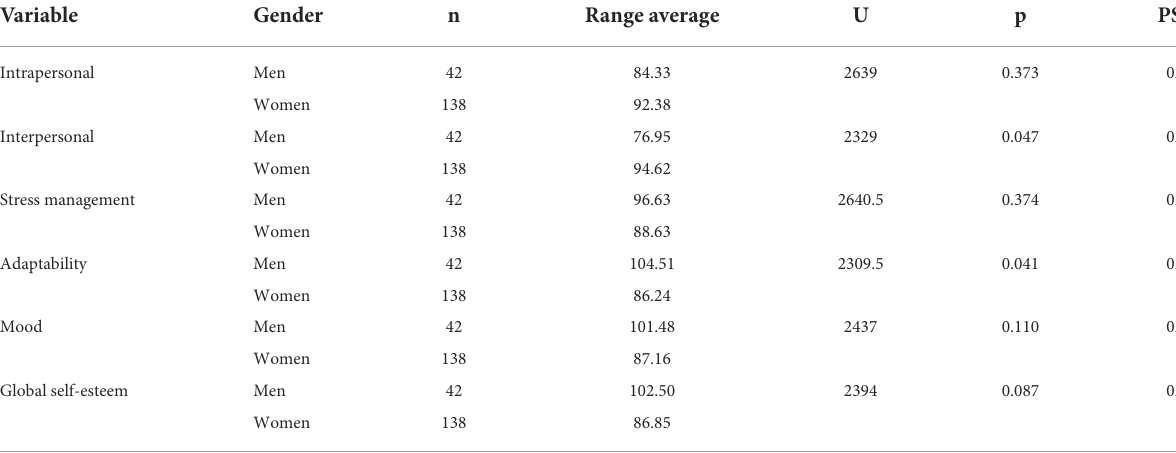
TABLE 3 Emotional intelligence and self-esteem: comparison by gender. Variable